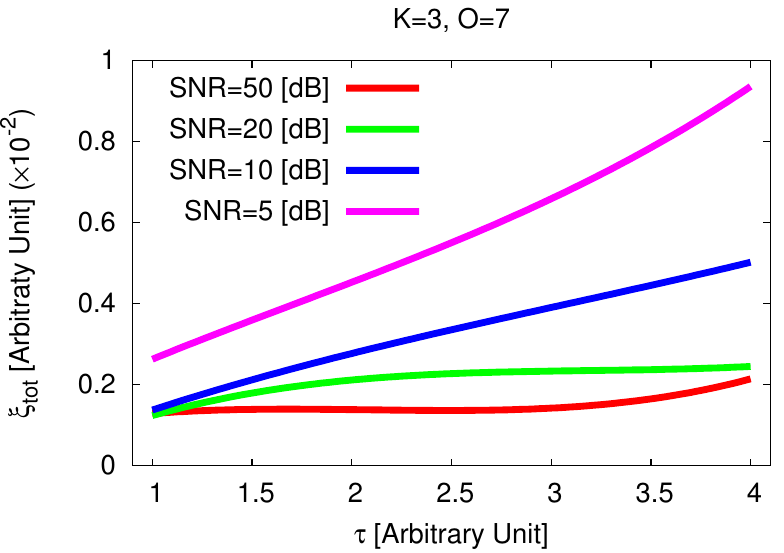
Figure 14. Numerical Assessment ( K = 3, O = 7, SNR ∈ [ 5, 50 ] [dB])—Behavior of the total reconstruction error ( ξ tot ) when processing the scattering data with the MT-BCS .